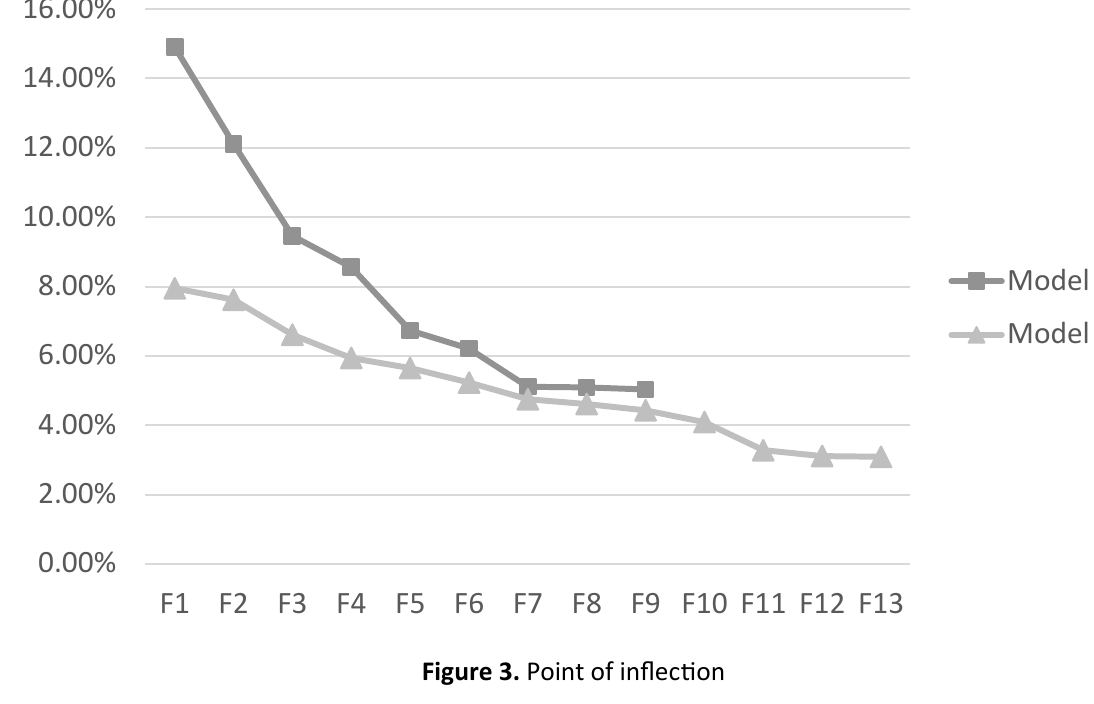
Figure 3. Point of